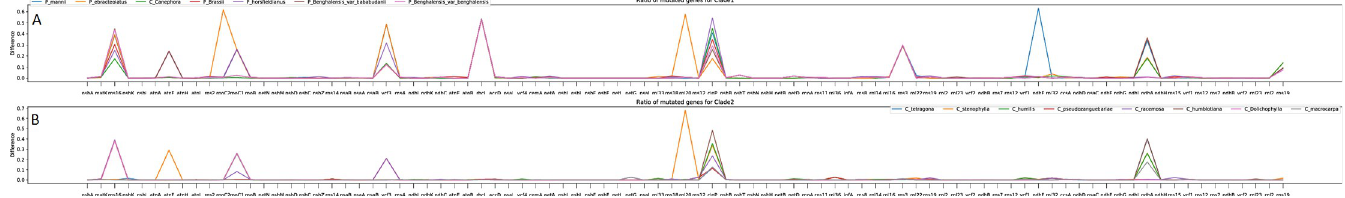
Fig 8. Gene mutation rates per species among each clade. The gene mutation rate between a species and its ancestor for a given gene is equal to the Levenshtein distance between the translated gene sequences of the specie and the ancestor divided by the length of their alignment. (A) Gene mutation rates between the species in clade 1 ( Psilanthus ) and the reconstructed ancestor of the clade. (B) Gene mutation rates between the species in clade 2 ( Coffea ) and the reconstructed ancestor of the clade.